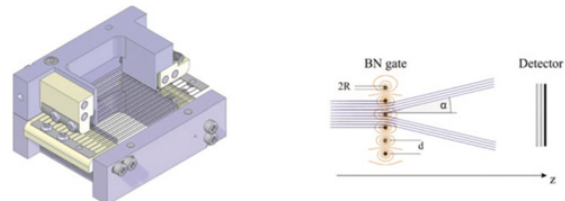
Figure 3. Left: A design drawing of a BN gate. Right: BN gate section view and functioning. The device consists of two insulated grids with equal + and − voltages, producing an electric field between the grid wires by means of which charged particles are deflected. At zero voltage, the particles pass the gates non- deflected. Neutral particles, e.g., metastable H(2s) hydrogen atoms, are de-excited into H(1 s) by means of the electric field. At zero field they remain to be H(2s).